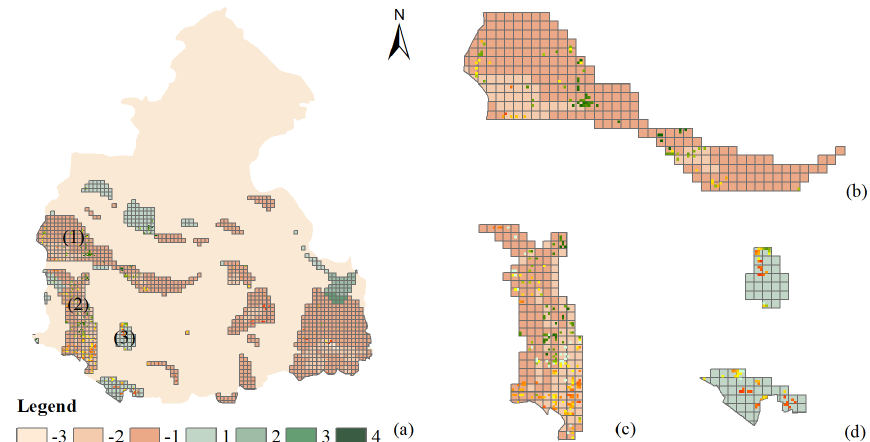
Figure 7. (a) Variation of the subsidence hazard level between FWBM and WBM. Negative and positive values mean that WBM has a higher or a smaller hazard level than FWBM, respectively. An amplification of areas (1)–(3) highlighted in panel (a) is provided in panels (b) – (d) , respectively. The colored dots represent the change in the land subsidence rate between 2010–2014 and 2015–2017 (the same as in Fig. 6c), with the green dots representing a lower hazard probability and the red dots a higher hazard